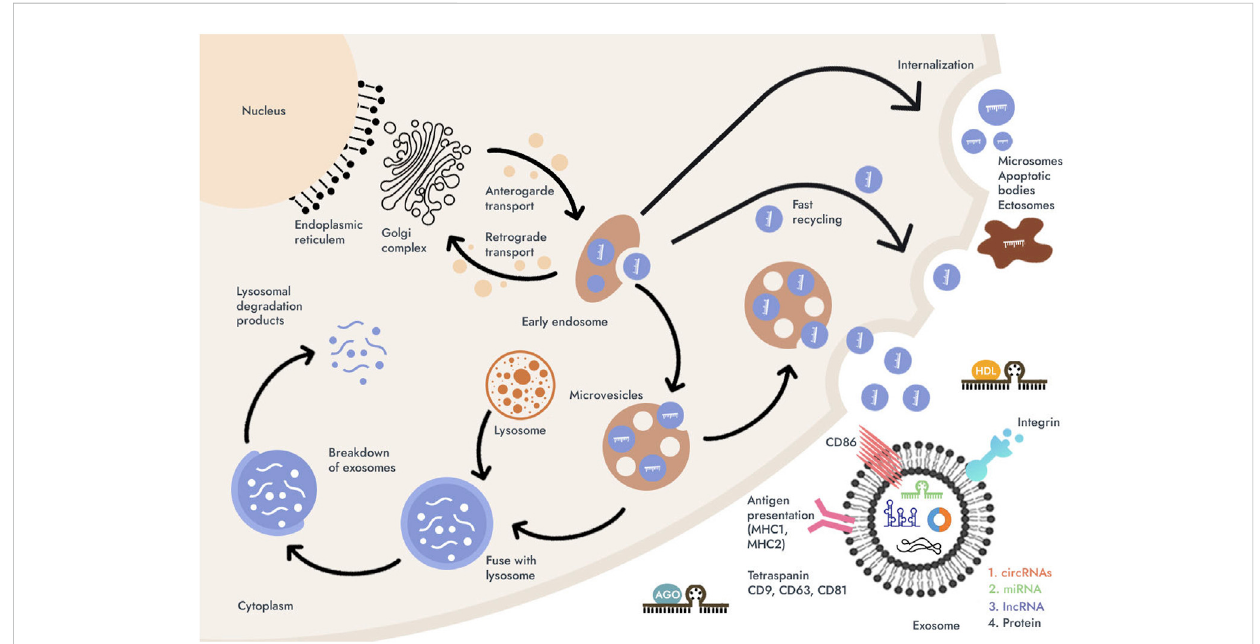
FIGURE 2 PossiblepathwaysforthesecretionofmicroRNAs(miRNAs),longnon-codingRNAs(lncRNAs),andcircularRNAs(circRNAs)intothebiological fl uids (blood or gastric juice) and their vehicles. MiRNAs, lncRNAs, and circRNAs can be secreted by the cell as microscopic extracellular vesicles (EVs) (exosomes and microvesicles) or released as part of apoptotic bodies; miRNAs can be found associated with high-density lipoproteins (HDL) and mostly in the form of complexes with Argonauts proteins (with Ago2). Then, regardless of the forms of miRNAs, lncRNAs and circRNAs pass from the extracellular space into the biological fl uid. About 90% of circulating miRNAs are in a non-vesicular form, namely, they are associated with Ago2. In addition to miRNAs, lncRNAs and circRNAs, exosomes contain a diverse array of molecules such as translation factors, metabolic enzymes, apoptotic proteins (Alix), proteolytic proteins chaperones, and contain other types of nucleic acids such as mRNAs. MiRNAs, lncRNAs, and circRNAs account for almost 50% of the total vesicular